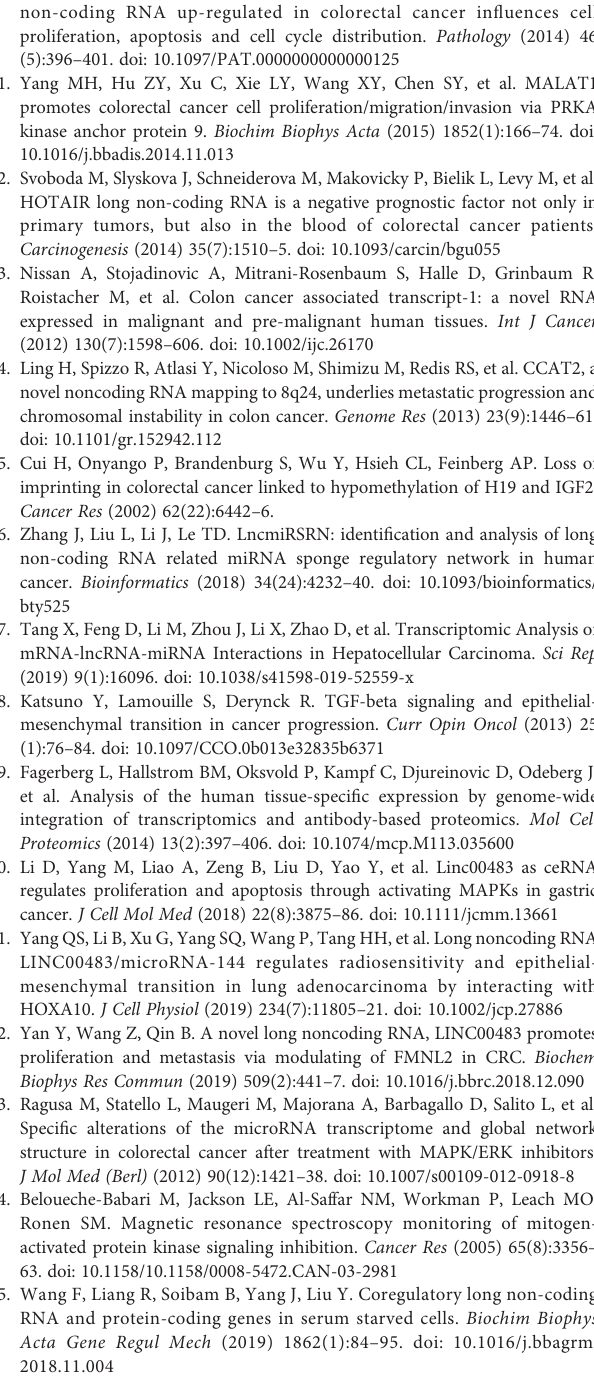
SUPPLEMENTARY FIGURE 1 | Schematic representation of lncRNA-miRNA- mRNA relationship based on the miRNA sponge model. SUPPLEMENTARY FIGURE 2 | Expression of LINC00483 and mRNAs associated with its molecular axes after 24 h serum starvation, with and without cell synchronization (complete